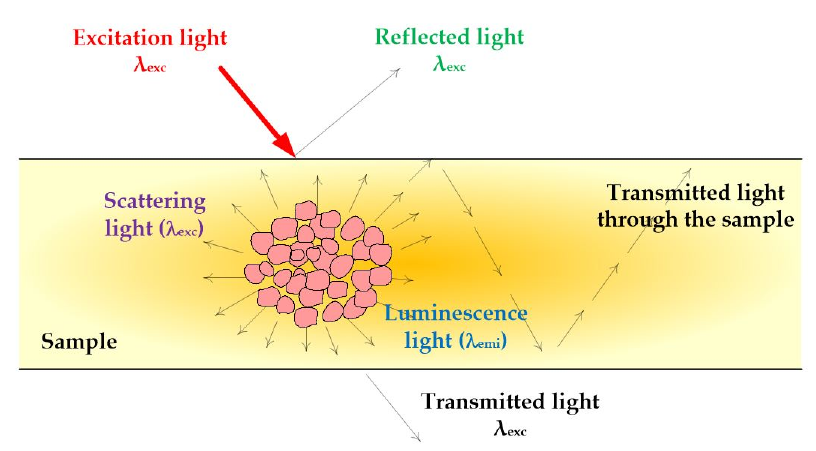
Figure 6. Optical phenomena due to light–matter